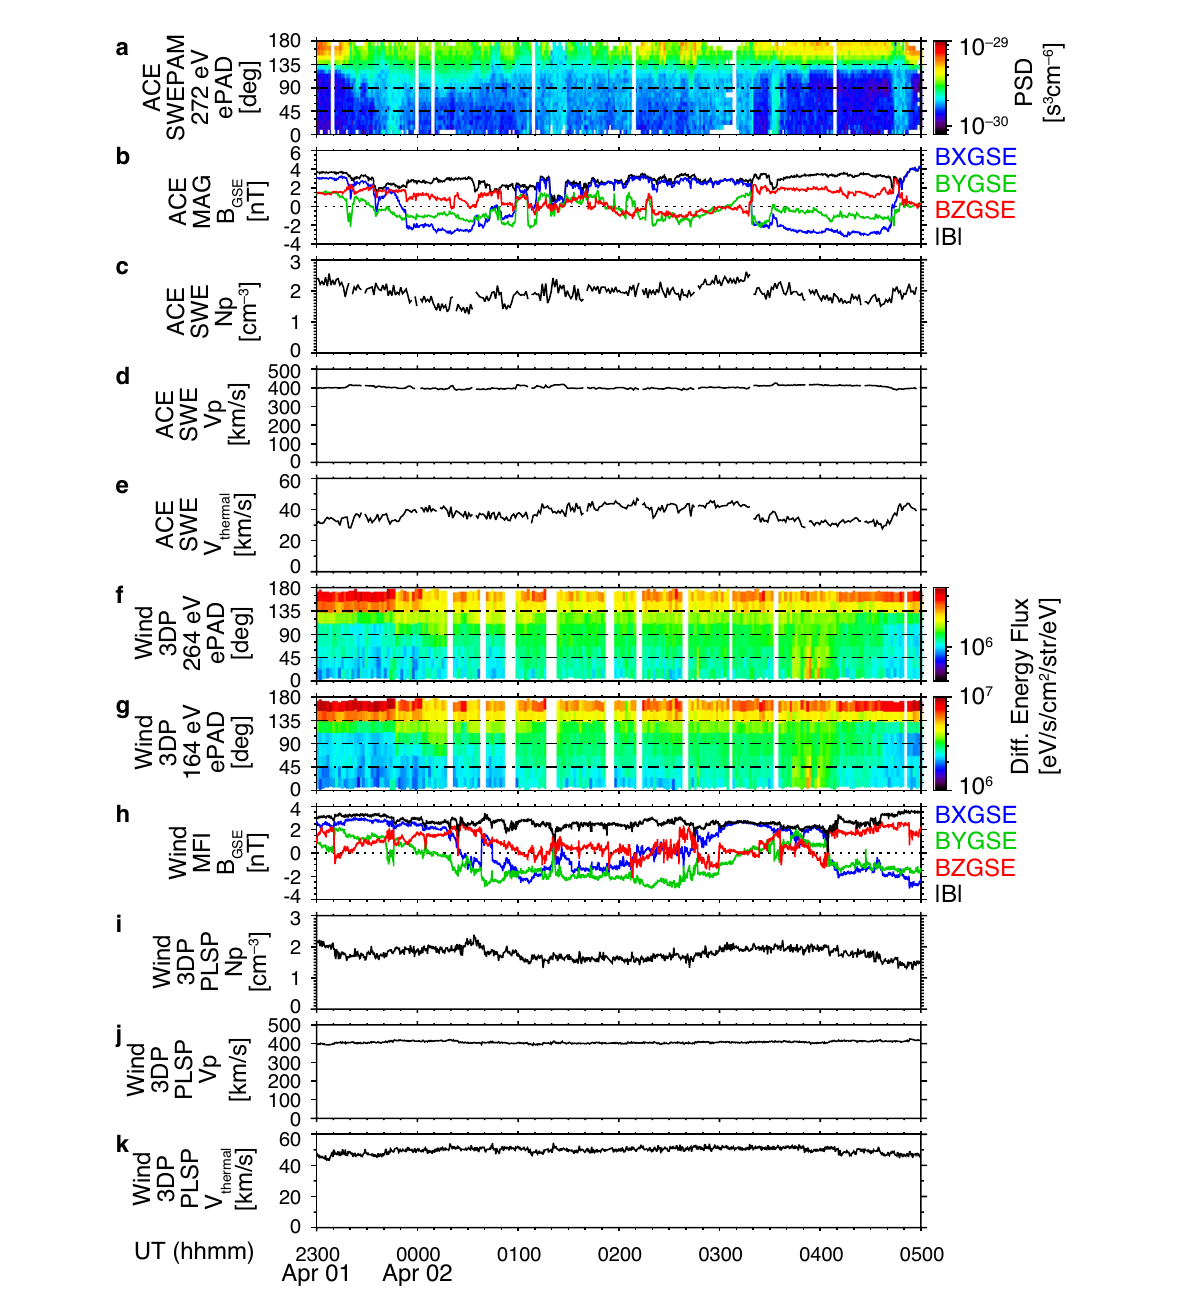
Fig. 4 Solar wind data observed by a – e ACE and f – k Wind spacecraft from 23:00 UT on April 1, 2008 to 05:00 UT on April 2, 2008. From the top, a 272-eV electron pitch-angle distribution in phase-space density; b magnetic field in GSE; c ion density; d ion bulk speed and e ion thermal speed at ACE, and f 264-eV electron pitch-angle distribution; g 164-eV electron pitch-angle distribution; h magnetic field in GSE; i proton density; j proton bulk speed and k proton thermal speed at Wind are plotted. The difference between the GSE and SSE coordinates is negligible in this